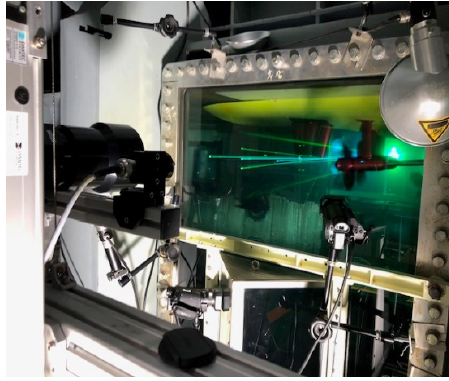
Figure 15. Rudder inflow measurements.